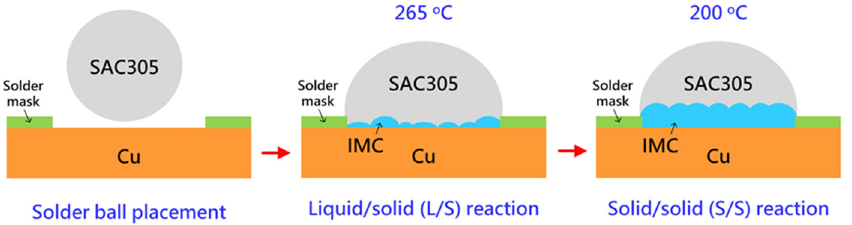
Figure 1. Schematic drawing of the preparation and configuration of the SAC305/Cu joints for liquid/solid and solid/solid reactions.